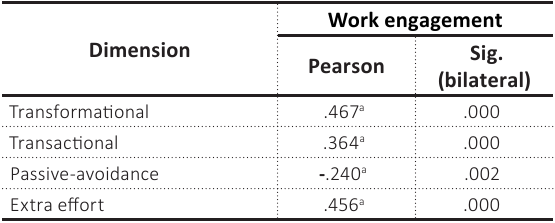
Table 2. Bivariate correlation analysis: